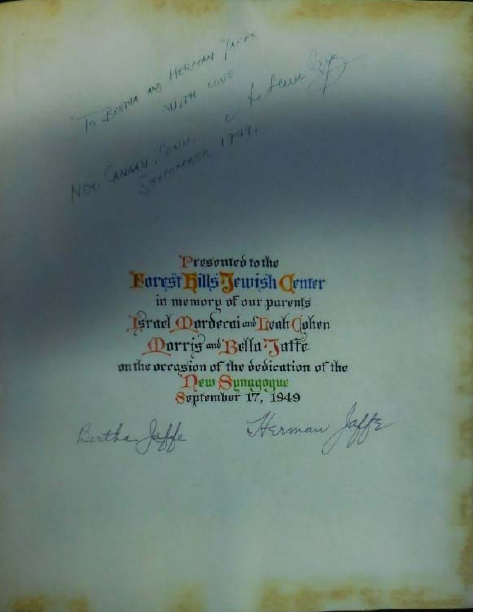
Figure 2. Dedication of the Haggadah by Szyk to the Jaffes.